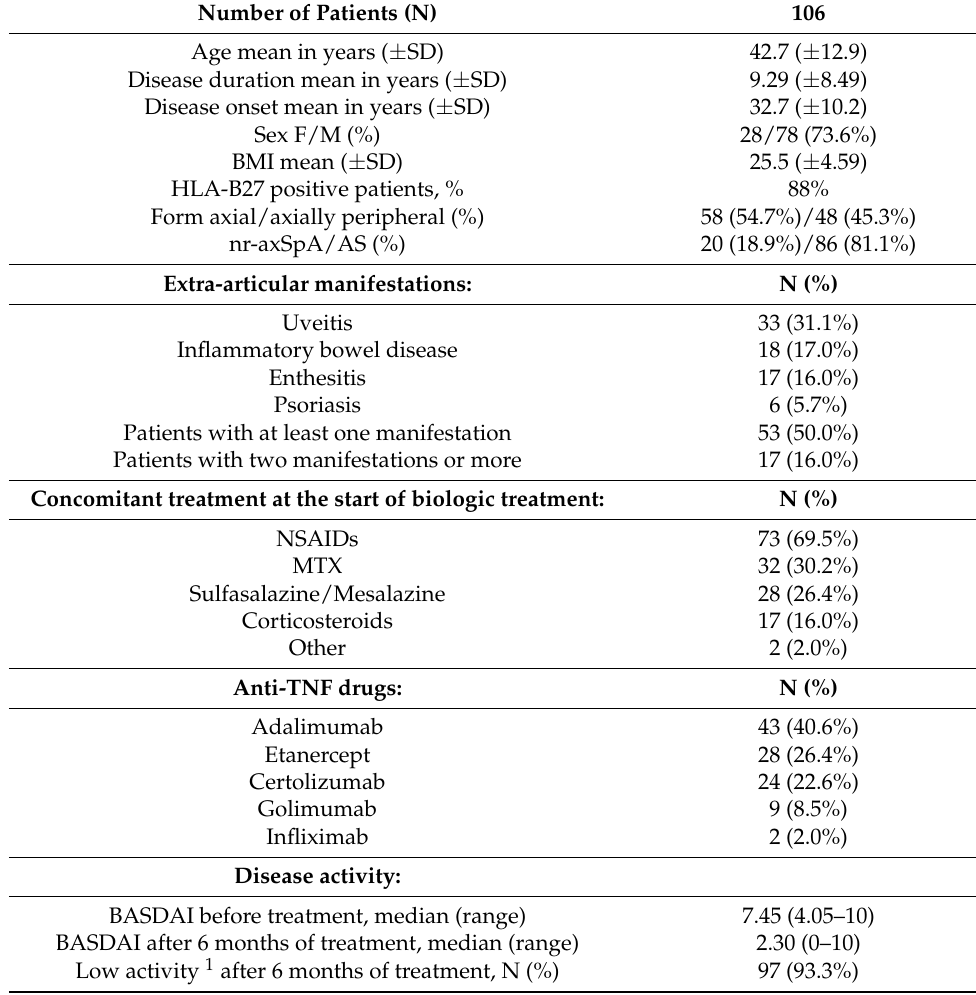
Table 1. Characteristics of the patient cohort included in the study. SD, standard deviation; F, female; M, male; nr-axSpA, non-radiographic axial spondyloarthritis; AS, ankylosing spondylitis; BMI, body mass index; HLA-B27, human leukocyte antigen B27; MTX, methotrexate; NSAIDs, nonsteroidal anti-inflammatory drugs; BASDAI, Bath Ankylosing Spondylitis Disease Activity Index. Number of Patients